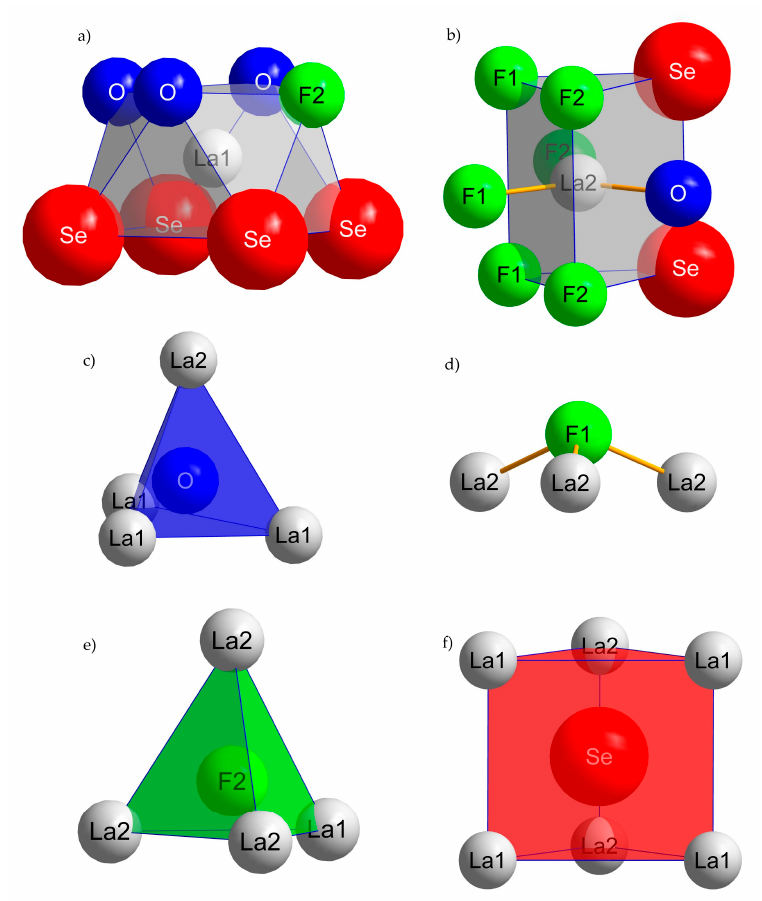
Figure 4. Coordination polyhedra in B-type La 2 OF 2 Se.